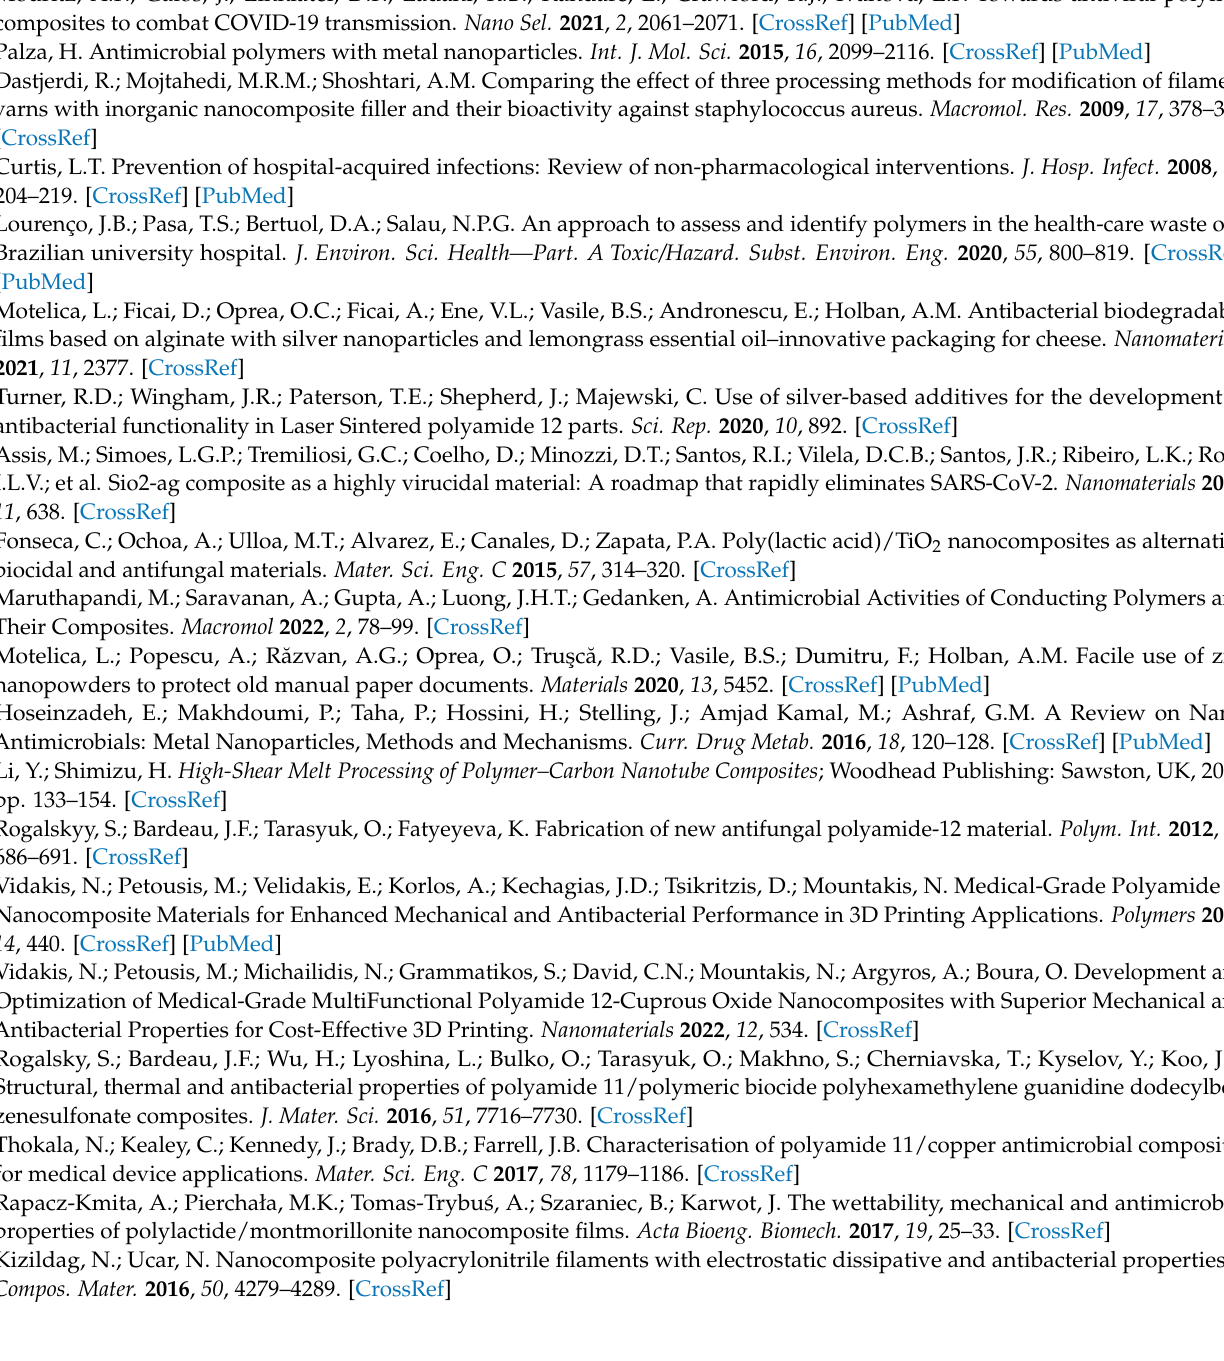
Figure A4. Fungistatic activity of the PA12 with metal oxides. C. albicans CFU on the YEPD agar growth medium inhibited under PA12 swatches contained 1, 2, 3, 4 and 5 wt% of metal oxides compared to the control PA12 without metal oxides. Visible confluent growth under the swatch as well as in proximity to the borders of a specimen.